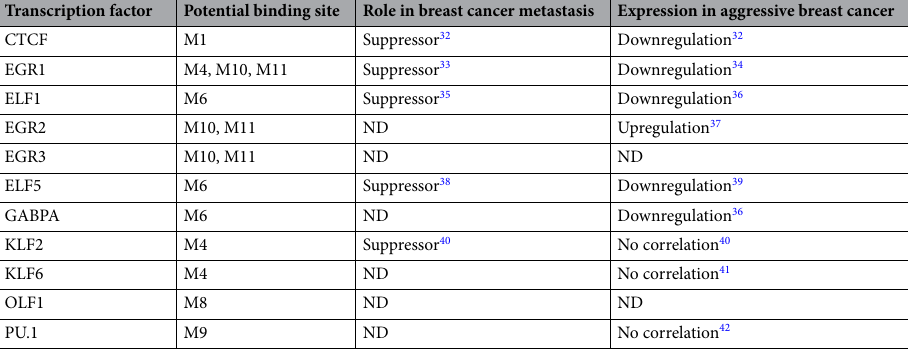
Table 2. Potential transcription factors binding to the proximal and/or minimal promoter regions of NME1 promoter. Transcription factors predicted to bind to significant binding sites according to mutagenesis studies (Fig. 2) are shown. ELF1, ELF5, and GABPA, represent the ETS family of transcription factors. The potential role in breast cancer metastasis and expression in aggressive breast cancer are also cited. ND not determined, NA not